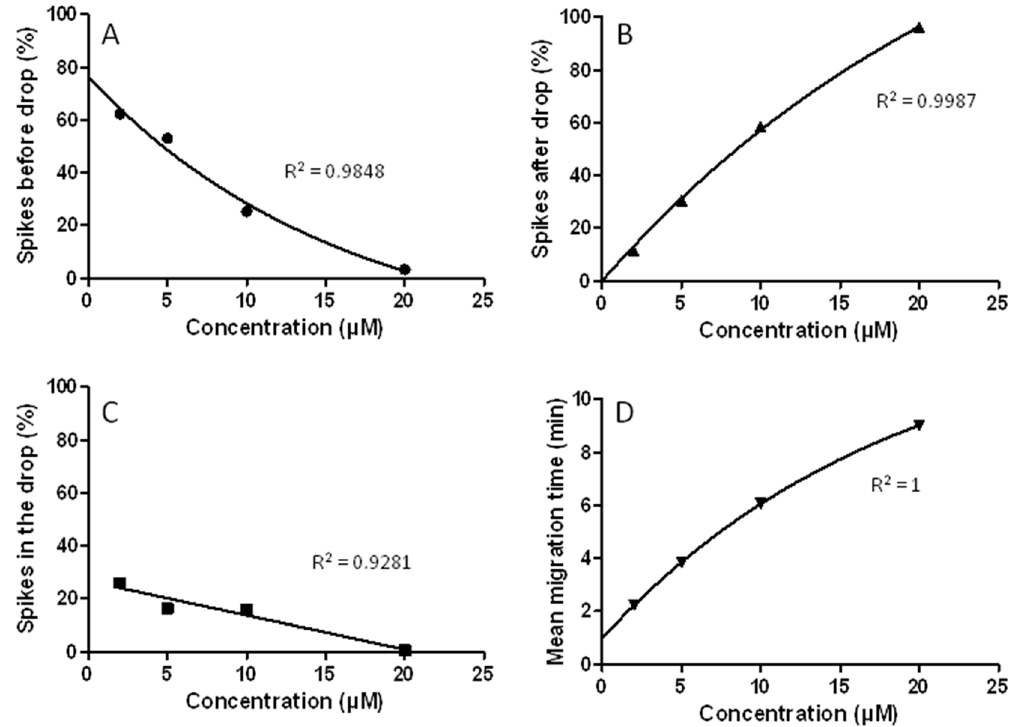
Figure 8. Effect of the concentration of 18 days incubated A β 1-40 on the migration time of spikes. ( A ): percentage of spikes before the drop in fluorescence due to the absence of thioflavine T in the sample. ( B ): percentage of spikes after the drop. ( C ): percentage of spikes migrating during the drop. ( D ): average migration time of the spikes. Running buffer as in Figure 1. Injection 2 psi/80 s. Curve fitting; ( A ): non-linear fitting, one phase decay; ( B ): non-linear fitting, one phase association; ( C ): linear regression; ( D ): non-linear fitting, one phase association.